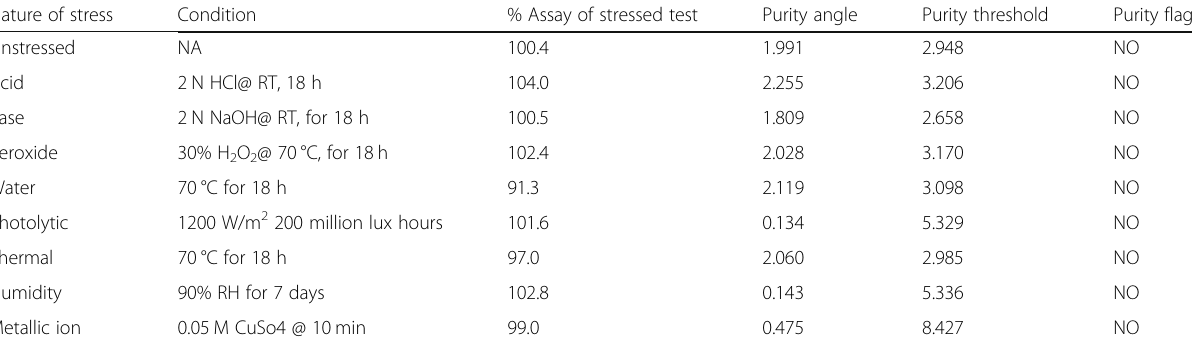
Table 2 Stress conditions for fulvestrant Nature of stress